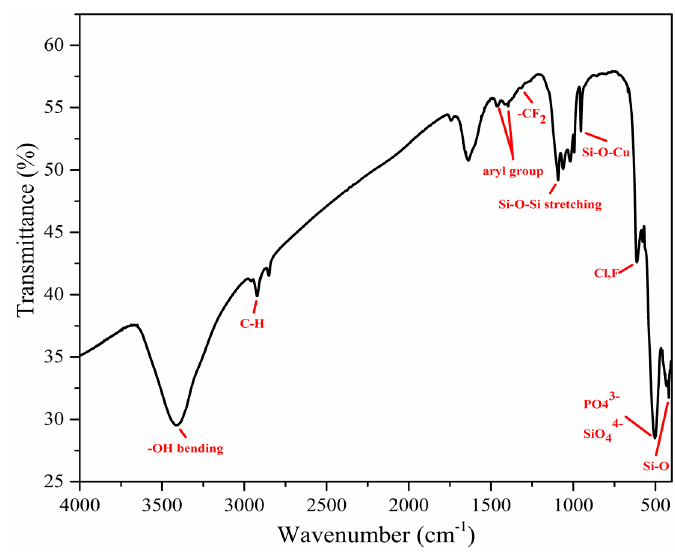
Figure 4. FTIR spectrum of the superhydrophobic copper surface.